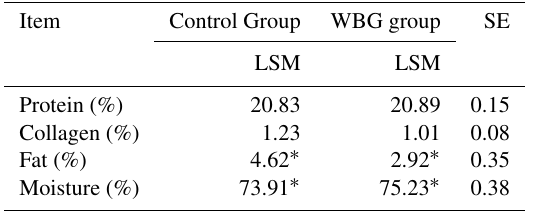
Table 6. The chemical composition of the meat of the control and WBG lambs.